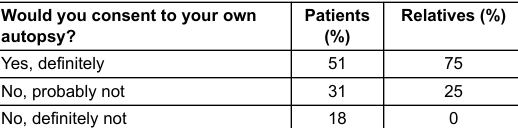
Table 5: Consent to own autopsy (questionnaire 2).